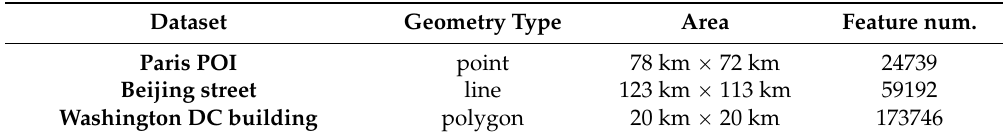
Figure 9. Thumbnail images of three experimental datasets. ( a ) Paris POI; ( b ) Beijing streets; and ( c ) DC buildings. Table 3. Three experimental